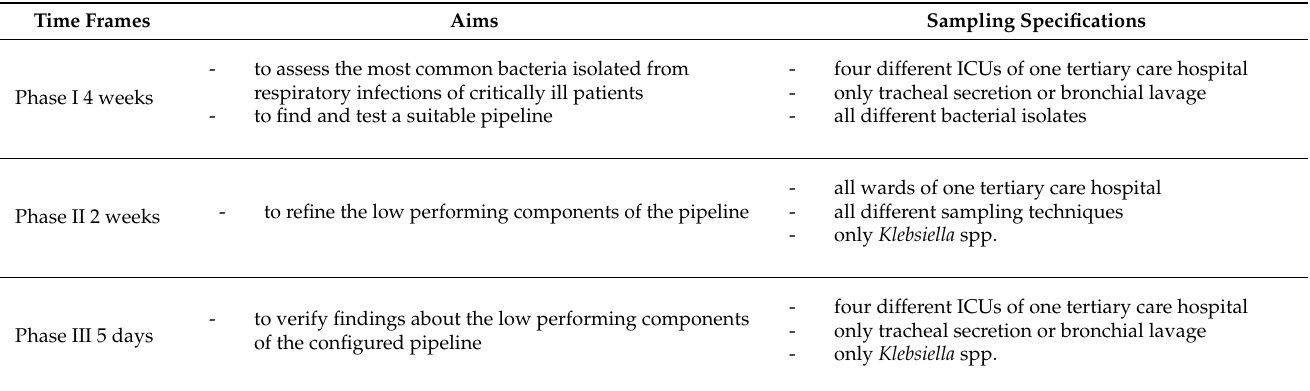
Table 2. Description of different phases of the study to set up, refine, and validate the phage delivery